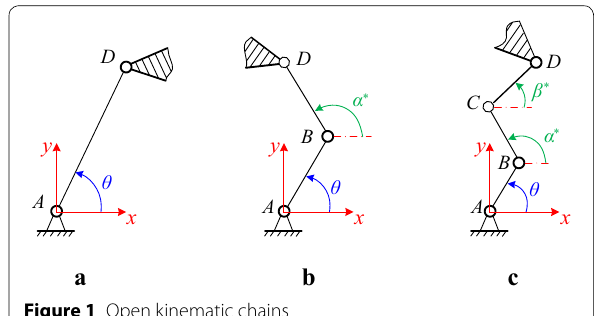
Figure 1 Open kinematic chains